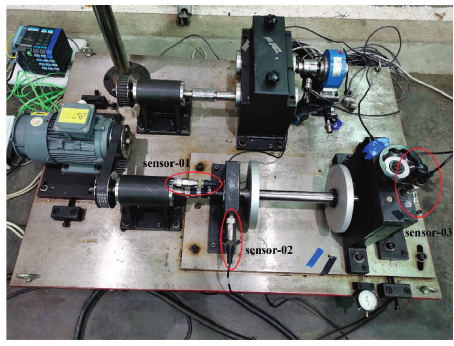
Figure 5: Fault simulation experiment platform.